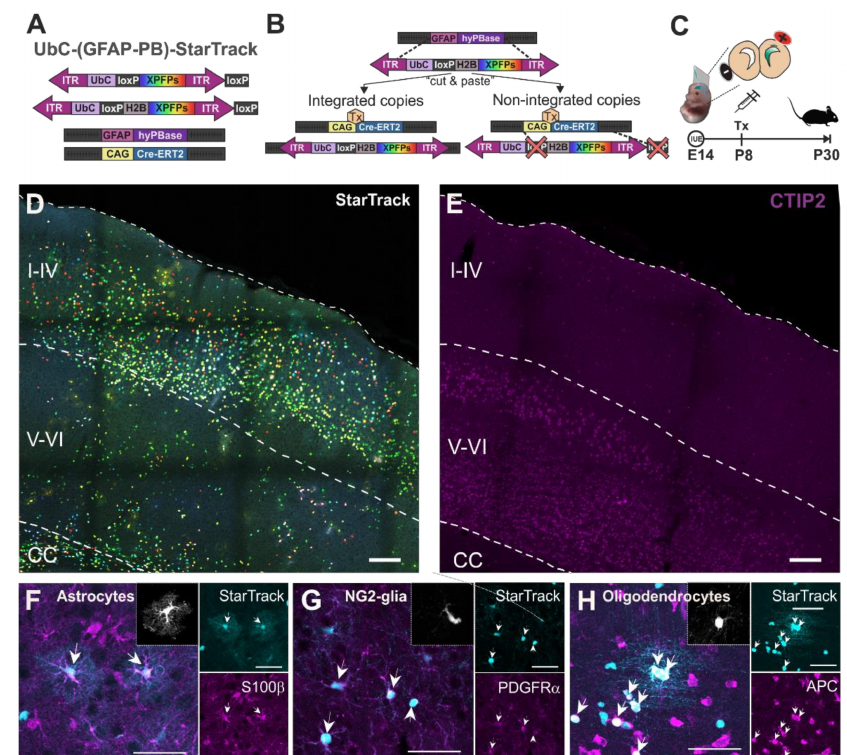
Figure 1. Adult glial cell progeny of targeted pallial E14-RGC progenitors with UbC-(GFAP-PB)-StarTrack in lower cortical layers. ( A ) Scheme of UbC-(GFAP-PB)-StarTrack , a genetic tool based on the PiggyBac system that enables the targeting of individual RGC progenitors to follow their complete cell progeny, independently of their lineage. This technique consists of the integration of 12 piggyBac plasmids under the UbC- promoter that encode up to 6 different fluorescent proteins (XFPs), located at the cytoplasm and/or the nucleus thanks to histone H2B. ( B ) The hyperactive PiggyBac transposase under the human GFAP promoter ( GFAP -hyPBase) recognizes the inverted terminal repeats (ITR) of PiggyBac plasmids, allowing it to stochastically integrate copies specifically in RGC progenitors at a single cell level and follow their complete cell progeny, independently of their lineage. In addition, plasmids are floxed by two lox-P , allowing the removal of non-integrated copies thanks to the Cre-loxP system after tamoxifen (Tx) intraperitoneal injection. ( C ) Analysis of adult (P30) cell-derived progeny after targeting pallial RGC progenitors at E14 by in utero electroporation (IUE) with UbC-(GFAP-PB)-StarTrack. Tamoxifen was administered at P8 to remove the non-integrated plasmids. ( D ) Adult cortical cell progeny of pallial RGC progenitors after targeting with StarTrack at E14. ( E ) CTIP2+ cells to delineate the lower cortical layers (V-VI). ( F ) StarTrack labeled astrocytes expressing S100 β . Inset shows the astrocyte morphology in a rendered image. ( G ) StarTrack labeled NG2-glia expressing PDGFR α +. Inset shows the NG2-glia morphology in a rendered image. ( H ) StarTrack labeled oligodendrocytes expressing APC+. Inset shows the oligodendrocyte morphology in a rendered image. Tx: tamoxifen; I-IV: upper cortical layers; V-VI: lower cortical layers; CC: corpus callosum. Scale bars in ( C , D ): 100 µ m; in ( E – G ): 50 µ